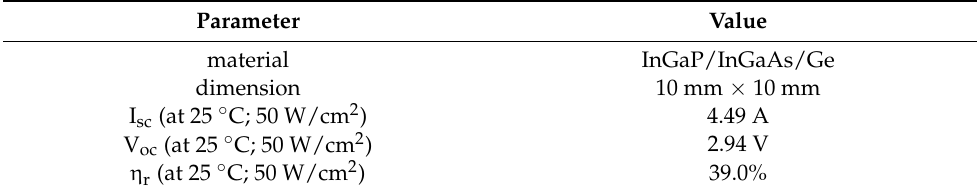
Table 1. Parameters of the triple-junction cell.